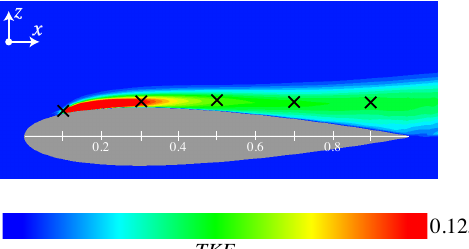
Figure 21. Turbulent kinetic energy (TKE) distribution in the Burst case at α =